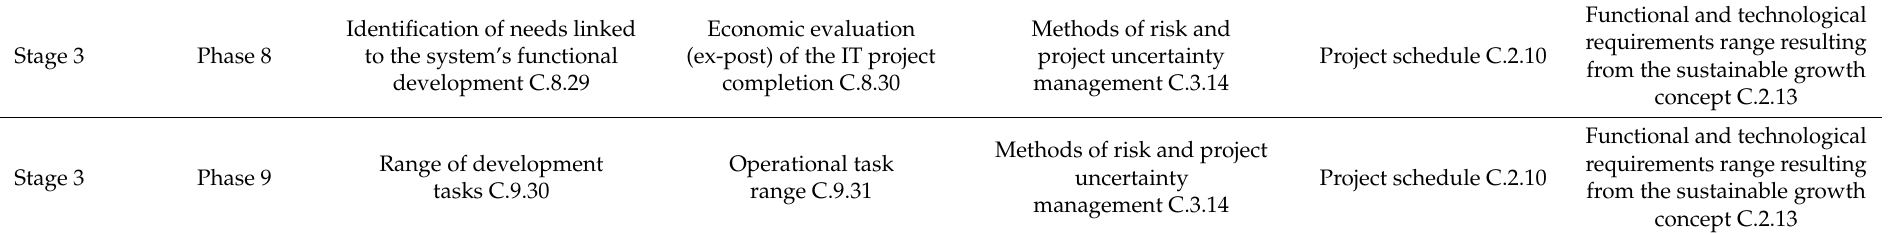
Table 5. The structure of information components on the client’s side during Stage 3 of the IT implementation projects. Source: Own study.